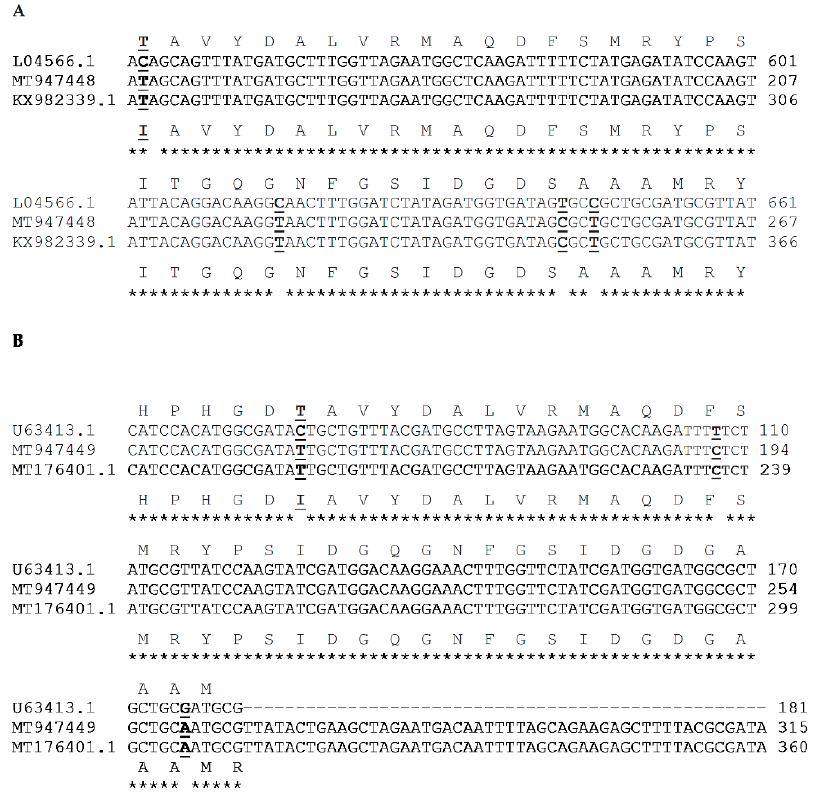
Figure 2. Mutations in gyr A sequences of C. jejuni ( A ) and C. coli ( B ). The mutation (Thr86Ile) is caused by the change from ACA to ATA ( C. jejuni ) and ACT to ATT ( C. coli ). Silent mutations in gyr A are also depicted. Mutations are bolded and underlined. L04566.1 and U63413.1 are standard strains (without mutation), while KX982339.1 and MT176401.1 are resistant strains. MT947448 and MT947449 are chicken isolates of this study.